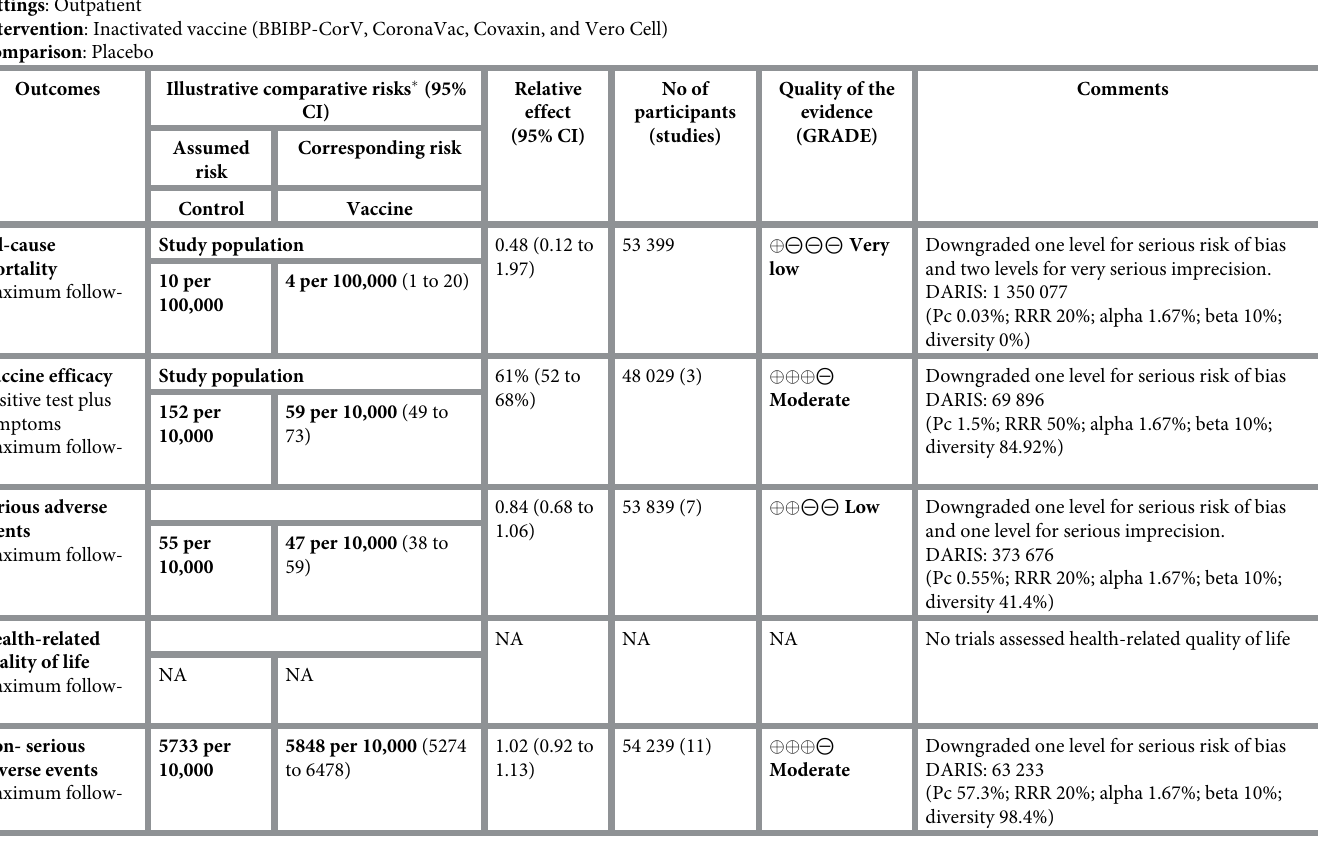
Table 1. Summary of findings (inactivated vaccines). Inactivated vaccines versus placebo Population : General population Settings :